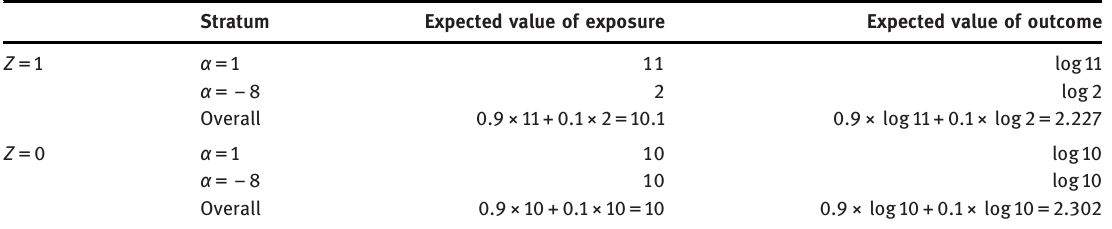
Table 2: Example 2: non-linearity and non-monotonicity. Instrumental variable estimate is 2.227 − 2.302 effect for all individuals (the outcome is an increasing function of the exposure).